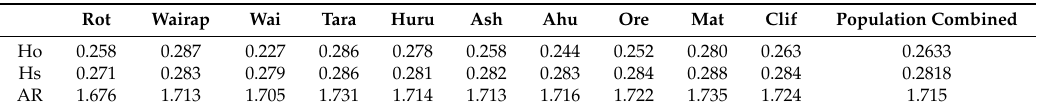
Table 2. Genetic diversity indices for black-billed gulls at each sampling site. Ho-observed heterozygosity, Hs-expected heterozygosity, AR—allelic richness. Rot—Rotorua,